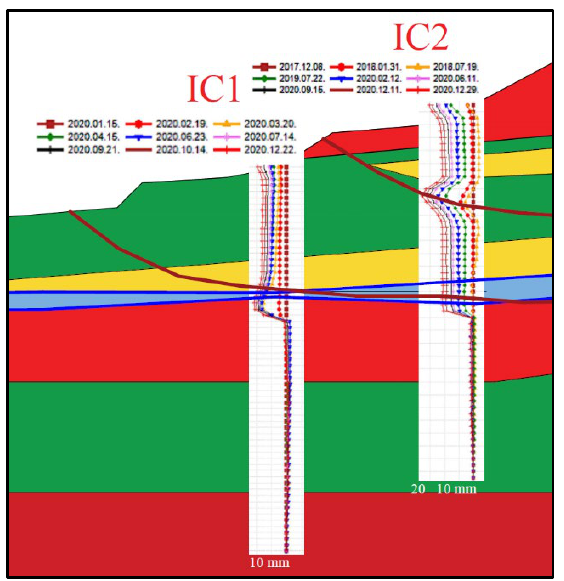
Figure 15. Displacements of IC1 and IC2 inclinometers with soil layers and sliding surfaces of the model result.